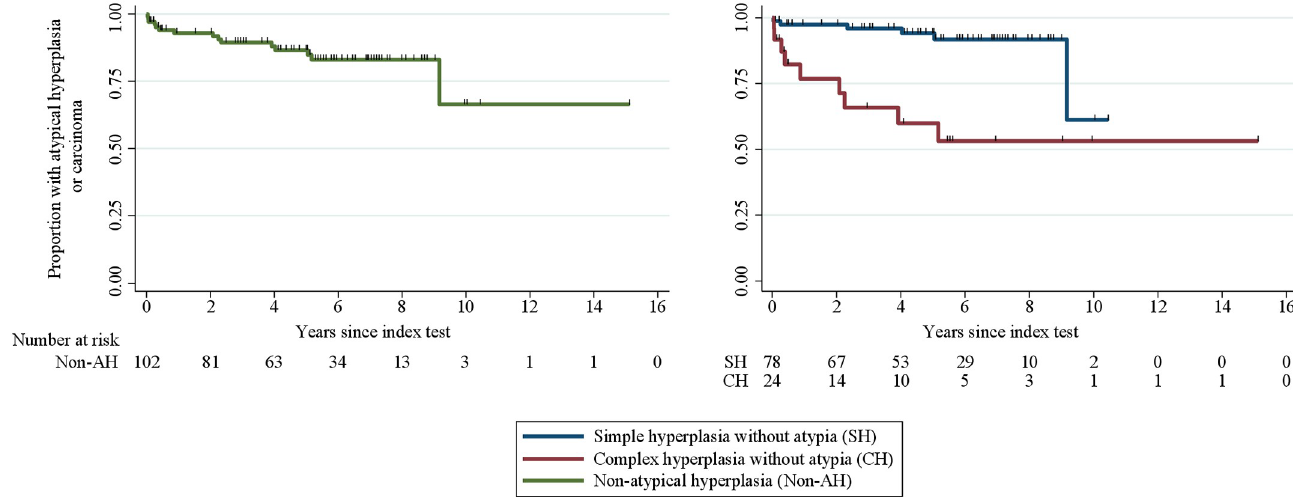
Fig 2. Subsequent atypical hyperplasia or endometrial carcinoma presented in all women with non-atypical hyperplasia (left) and according to WHO 1994 classification type of non-atypical hyperplasia (right). The endpoint was atypia or carcinoma. Women were censored (black lines) due to hysterectomy, follow-up biopsy, or death. The women in whom follow-up biopsies were not obtained or in whom the biopsy material obtained was insufficient for diagnostic evaluation were censored on the day of their follow-up clinical examination.